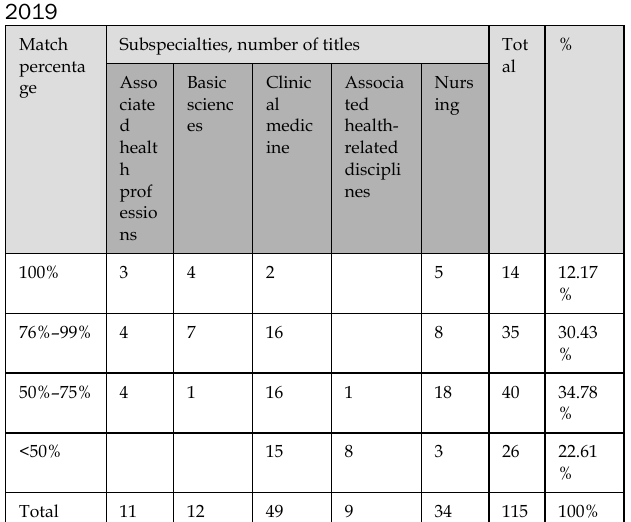
Table 2 Percentage of match of the subspecialties to DCT